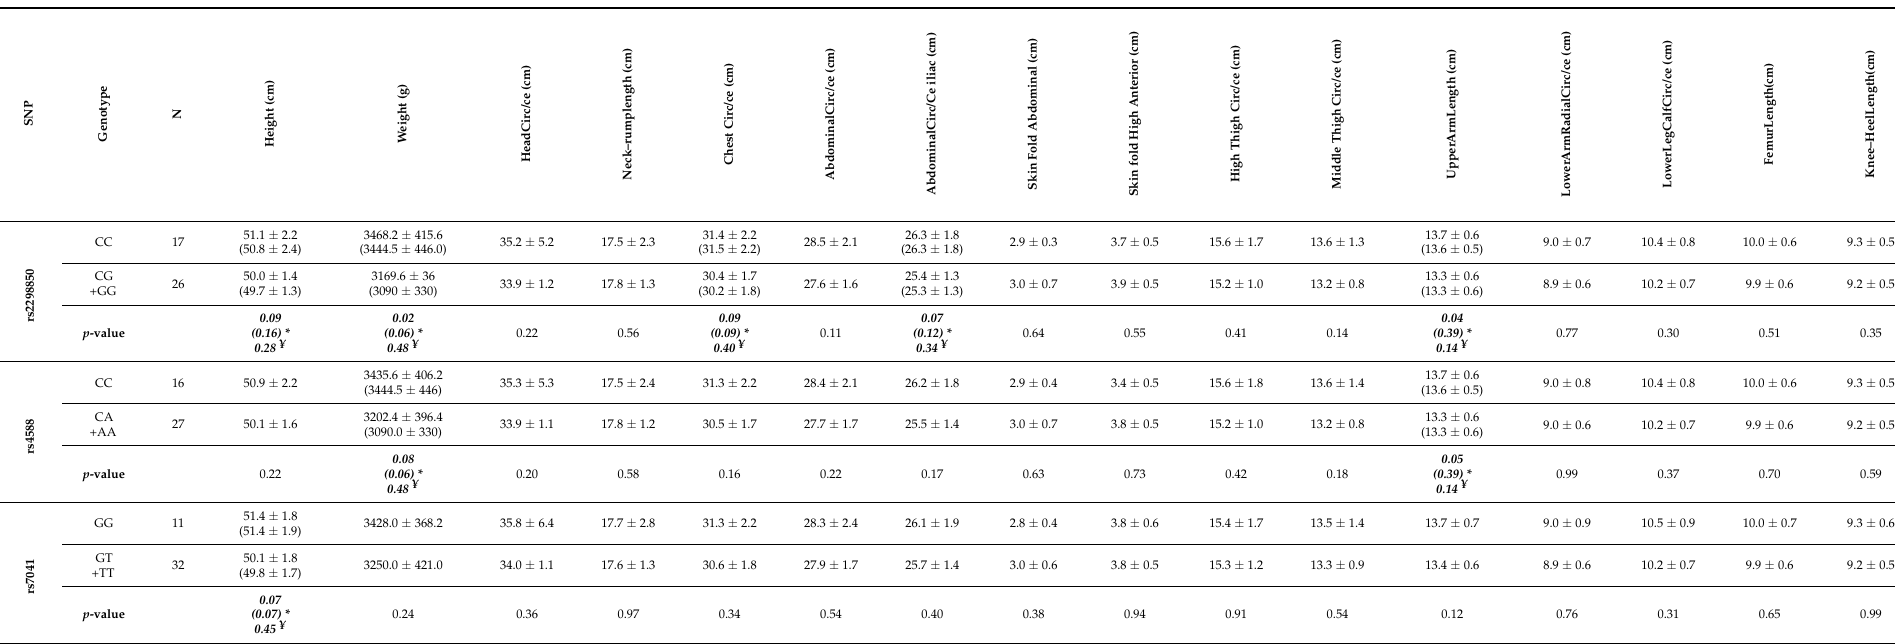
Table 3. Birth neonatal anthropometry (maternal 25(OH)D ≤ 50 nmol/L) according to maternal VDBP polymorphisms. If Levene’s Test for Equality of Variances p > 0.05 then Equal variances assumed Sig (2-tailed) p -values of T-Tests were given. If Levene’s Test for Equality of Variances p < 0.05 then Equal variances not assumed Sig (2-tailed) p -values of T-Tests were given. * The data and p -values adjusted for maternal height (cm), BMI pre-pregnancy (kg/m 2 ), BMI terminal (kg/m 2 ), UVB exposure, and weeks of gestation by One-way analysis of covariance (ANCOVA), Numbers in italics are after adjustments. ¥ Observed power